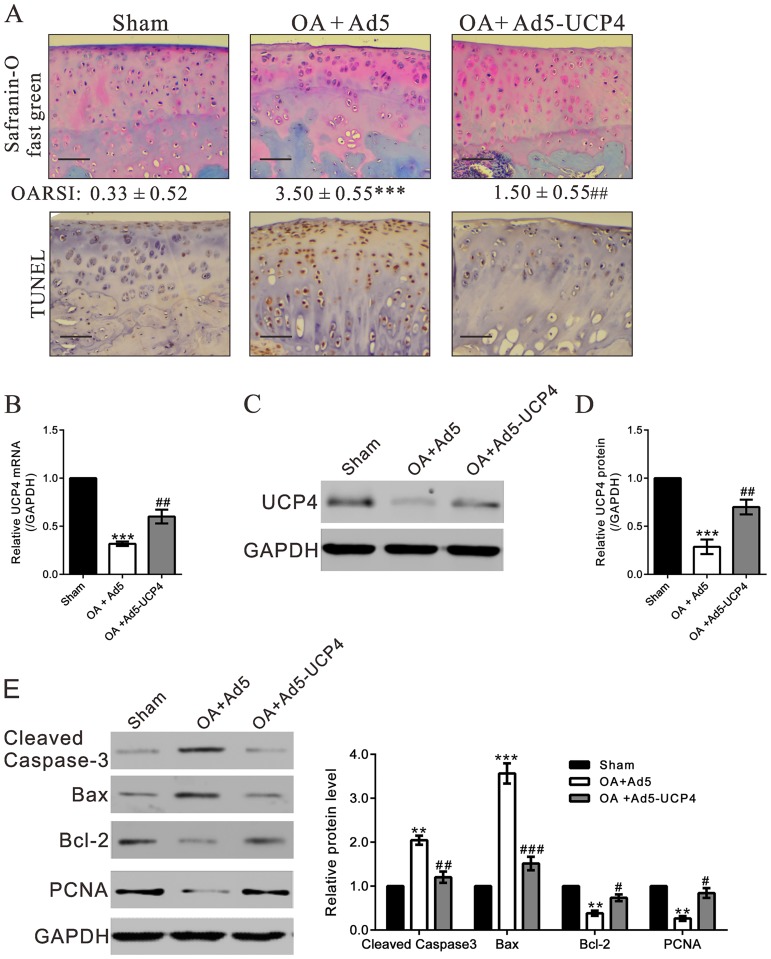
Treatment with UCP4 adenovirus attenuated OA progress in a rat model.(A) Evaluation of histological changes and cell apoptosis in the cartilages by Safranin-O/fast green and TUNEL staining, respectively. OARSI score from three groups of rats (n = 6) was shown. Scale bar: 100 μm. (B, C, D) The mRNA and protein level of UCP4 in rat cartilage tissues were detected. (E) Expression of Cleaved-Caspase-3, Bax, Bcl-2 and PCNA was evaluated by Western blot. **P<0.01 and ***P <0.001 versus sham-operated group (Sham). #P <0.05, ##P<0.01 and ###P <0.001 versus ACLT surgery and Ad5-treated group (OA+Ad5).